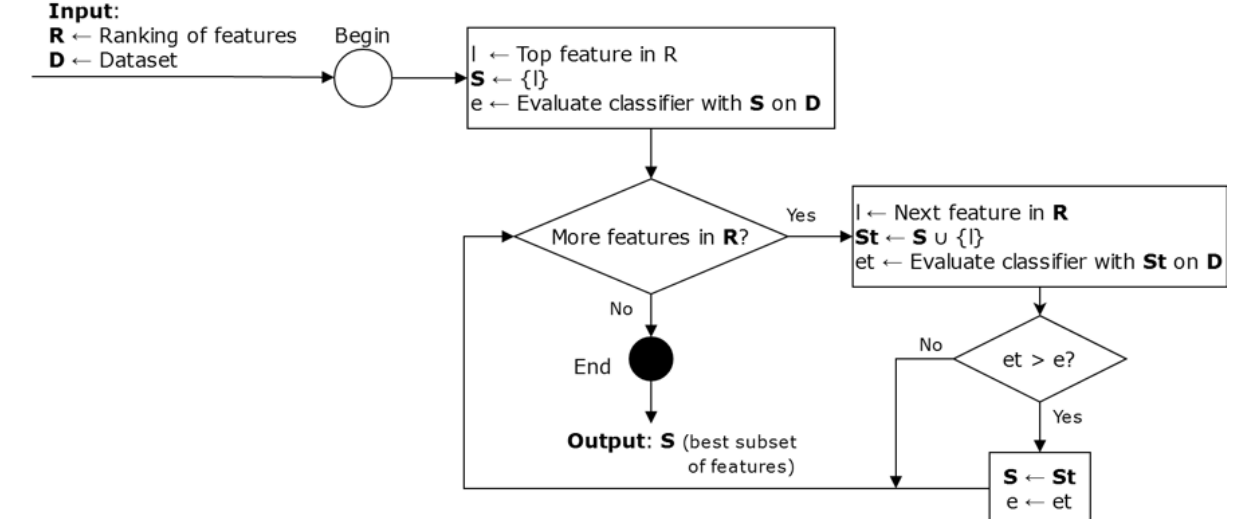
Figure 2. Flowchart to create classifiers with optimal subsets of